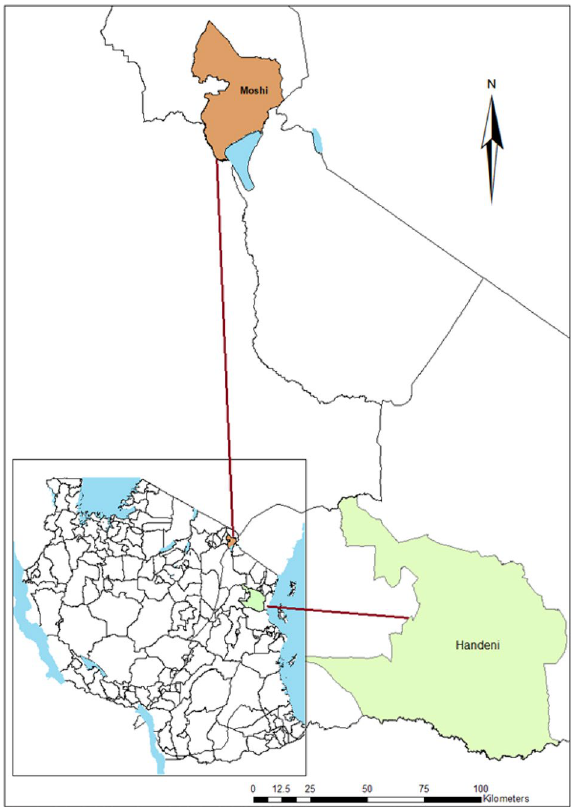
Figure 3. A map of Tanzania showing the study areas (map created using ArcGIS software